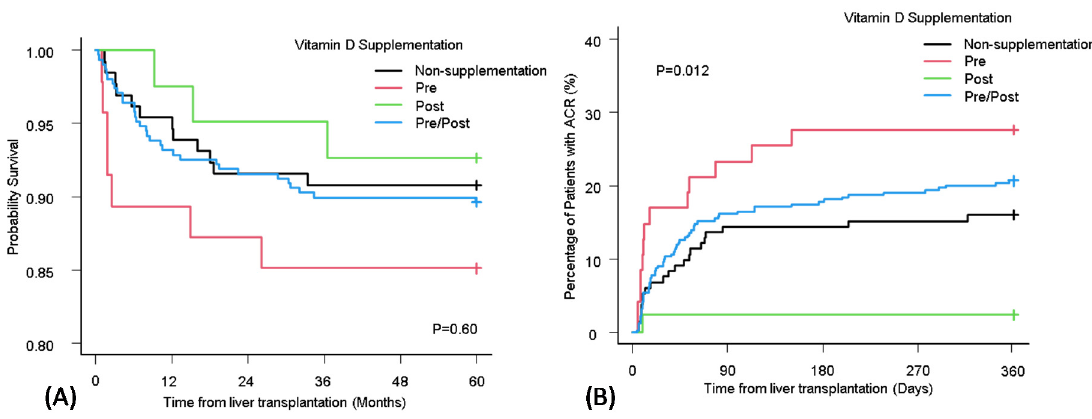
Figure 4. Comparison of vitamin D supplement status in OS ( A ) and the accumulate incidence of ACR ( B ). ACR: acute cellular rejection; OS: overall